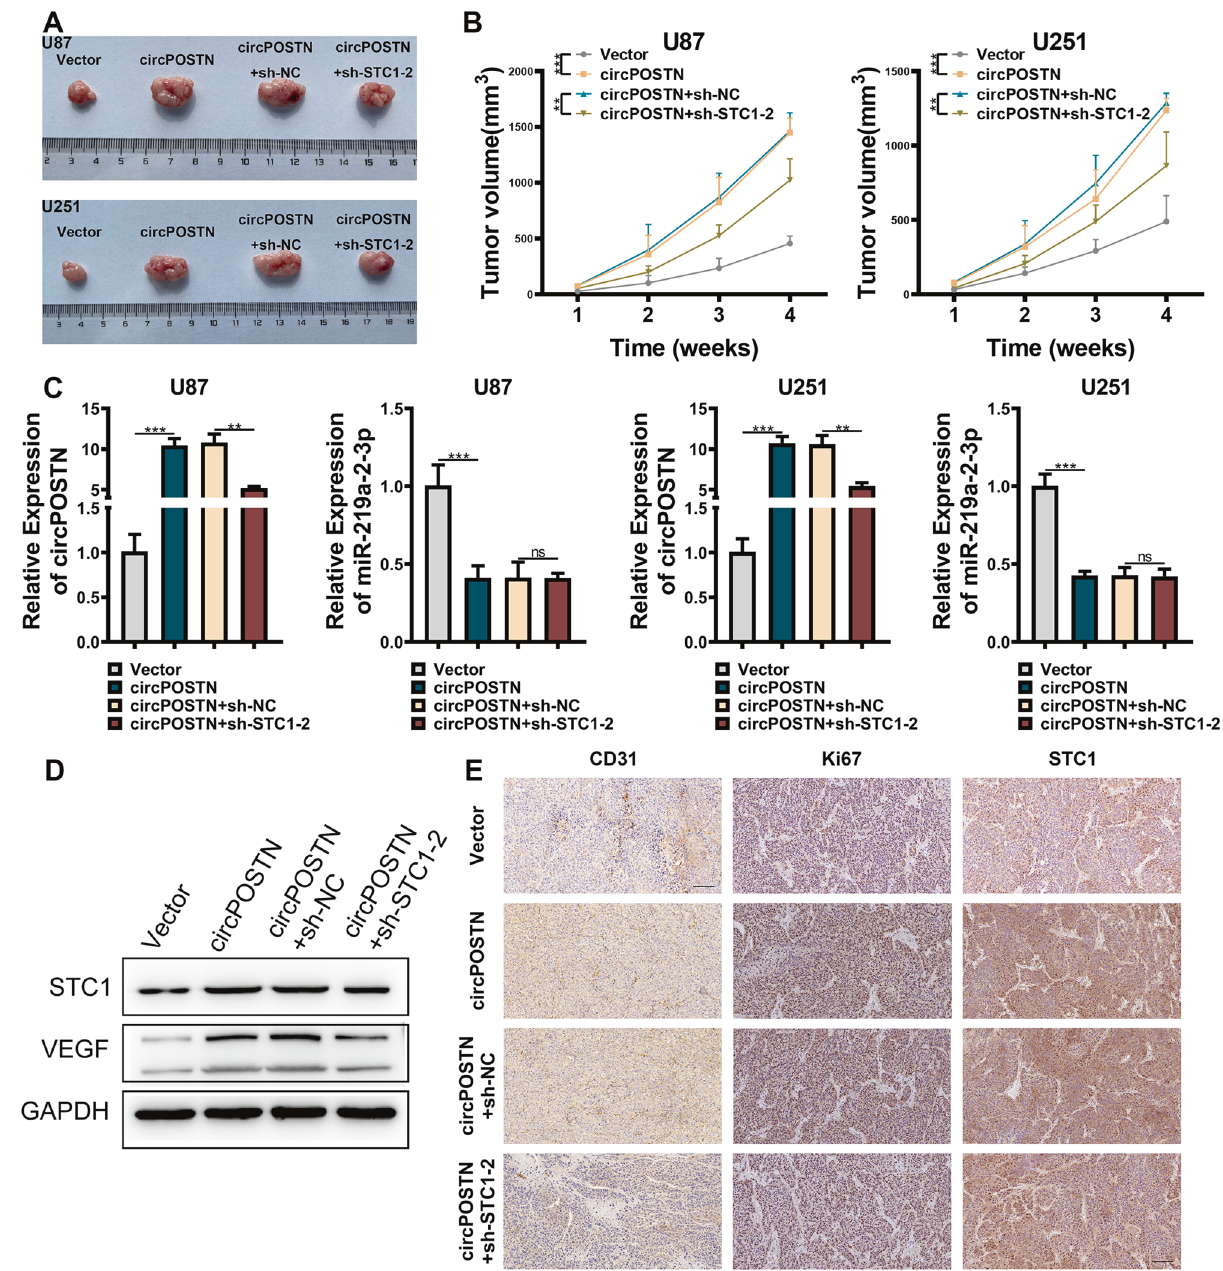
Fig. 7 The overexpression of circPOSTN boosts GBM tumorigenesis in vivo. A – E The U87 and U251 cells were stably overexpressed with the circPOSTN. Then, the cells were stably transfected with shRNAs targeting the STC1 gene or the negative control (sh-NC). The nude mice were randomly divided into four groups: Negative control (Vector), circPOSTN overexpression (circPOSTN), circPOSTN overexpression with sh- control (circPOSTN + sh-NC), and circPOSTN overexpression with STC1 silenced (circPOSTN overexpression + sh-STC1-2). The U87 and U251 cells were subcutaneously implanted into the nude mice to generate the xenograft tumor models. A The representative images of subcutaneous xenograft tumors stripped from nude mice. B The growth curve of subcutaneous tumors was plotted by measuring the tumor volume every week. C Quantitative RT-PCR was used to analyze the expression levels of circPOSTN and miR-219a-2-3p from xenograft tumors. D Western blotting analysis for the expression levels of STC1 and VEGF proteins of subcutaneous tumors. GAPDH was used as endogenous control. E The representative images of IHC staining for STC1, Ki-67, and CD31 in subcutaneous tumors. Data are presented as the mean ± SD. ** P < 0.01, *** P < 0.001. NS not signi fi